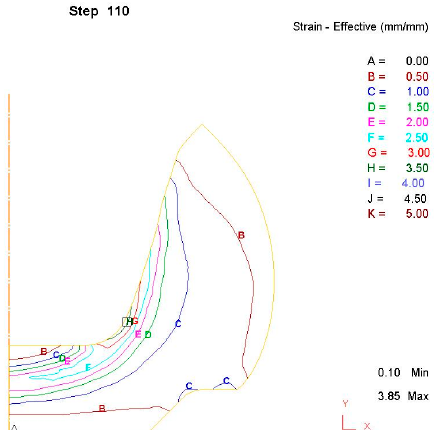
Figure 11. Contours of effective strain obtained at a stroke of 11 mm in finite element simulation for 380 °C/0.01 mms − 1 (Corresponding to Domain 1). The contours are shown from central axis on half portion of the forged specimen corresponding to the diametral plane.